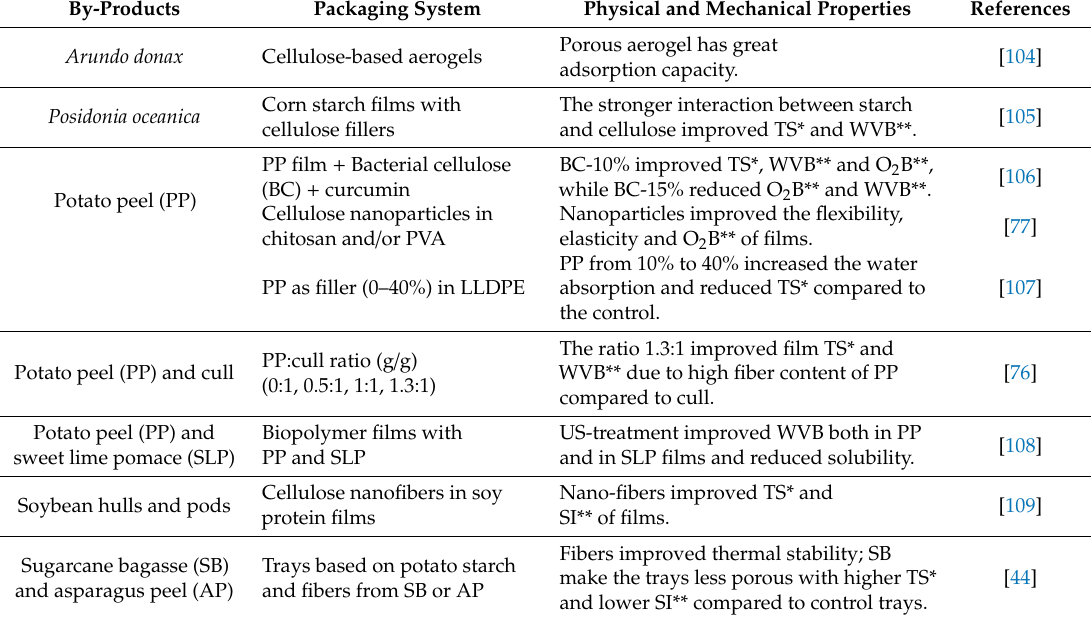
Table 4. Vegetable by-products and e ff ects on physical and mechanical properties of films. By-Products Packaging System Physical and Mechanical Properties Porous aerogel has great adsorption capacity.